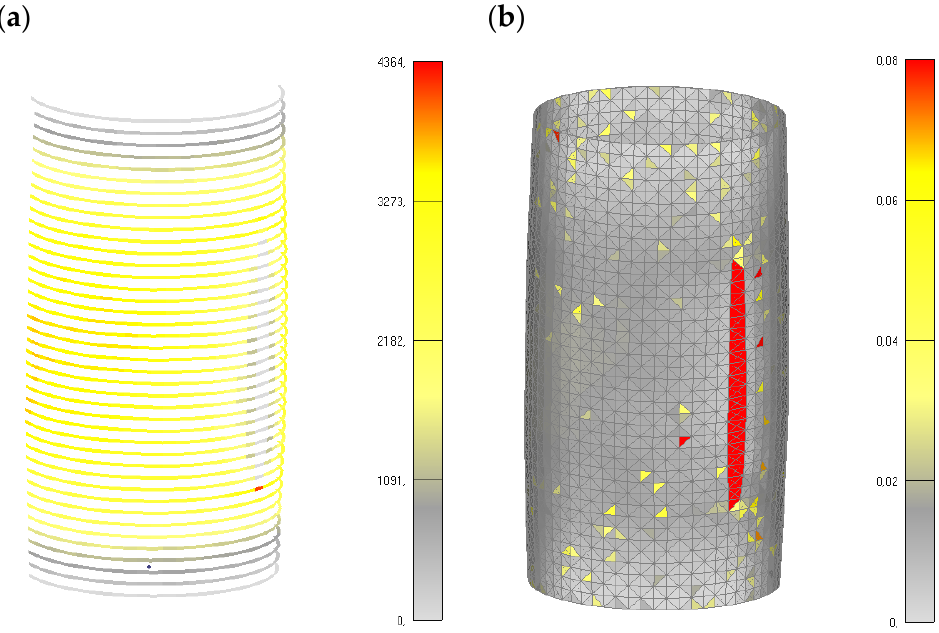
Figure 13. Typical failure mode R 75: ( a ) tensile rupture of fibers and ( b ) damage inside the resin.